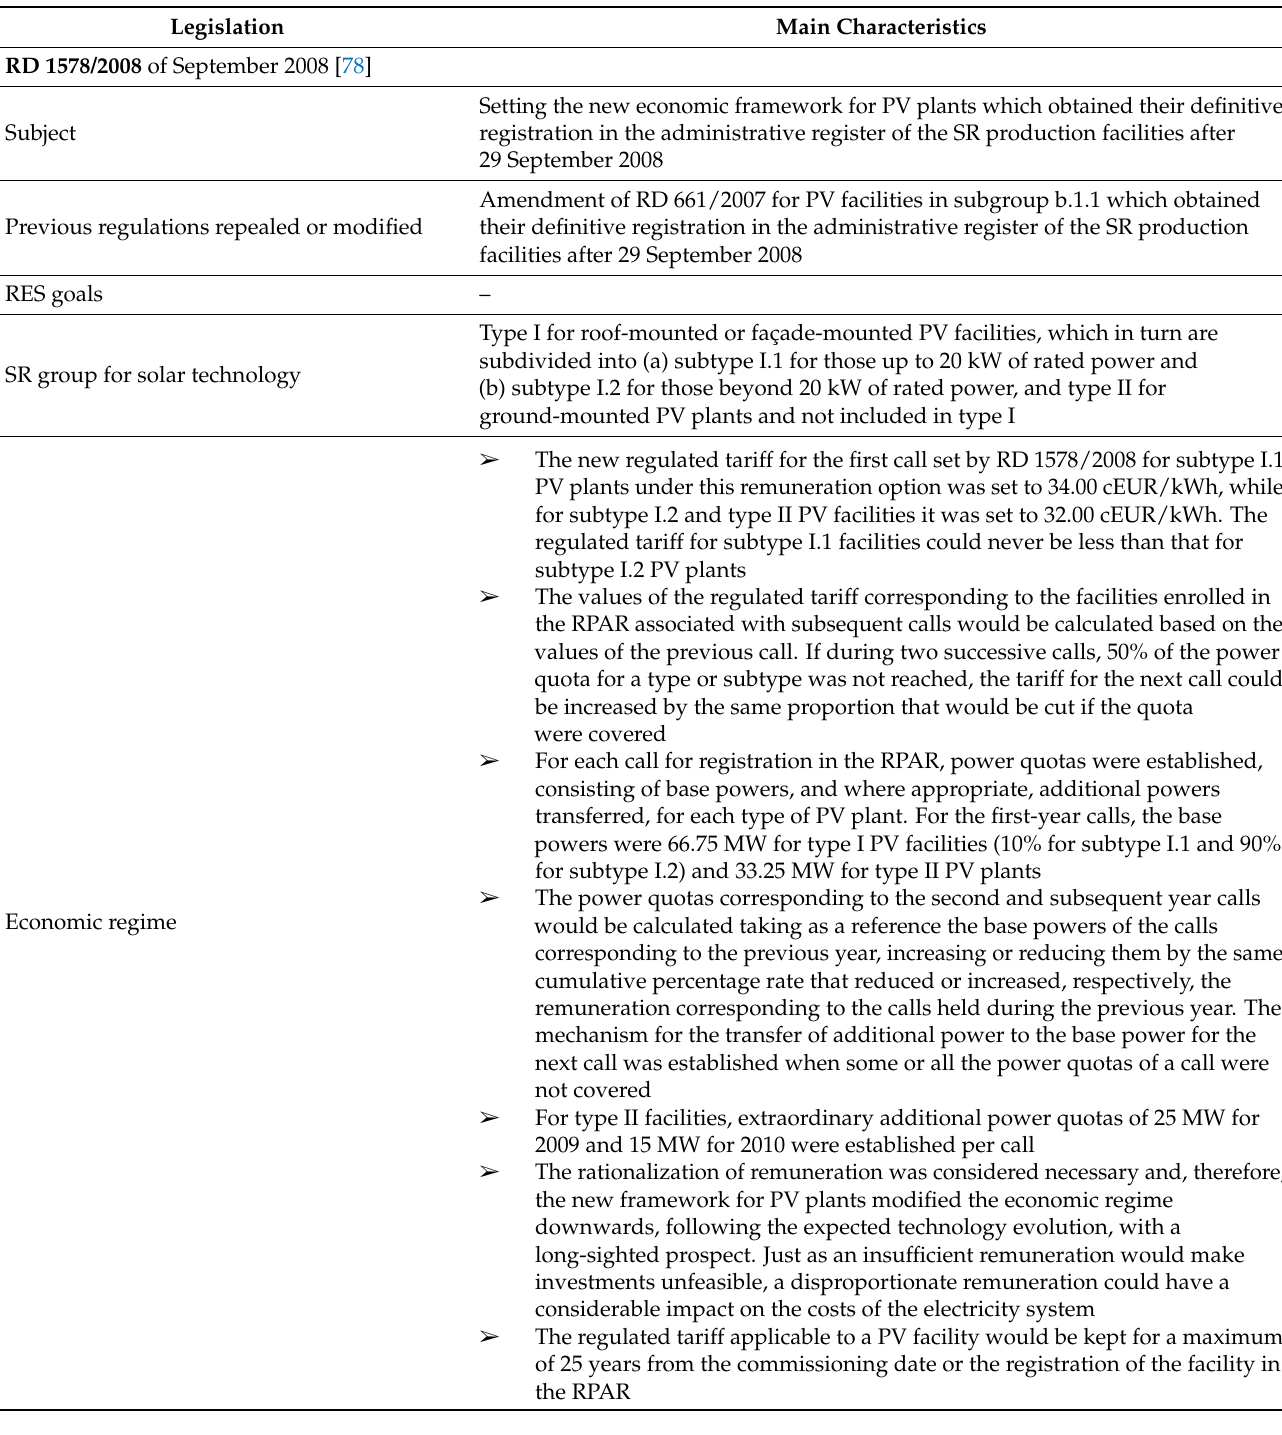
Table 5. Major characteristics of the different regulatory frameworks in force for solar power